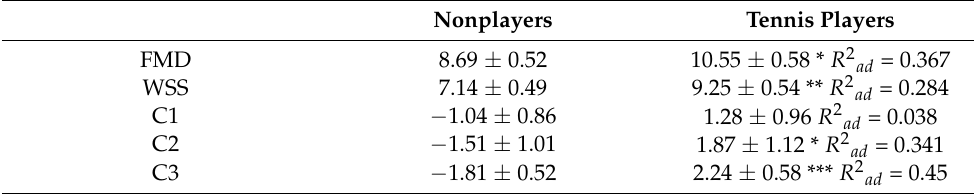
Table 5. Analysis of covariance of the FMD, WSS, Cluster 1, Cluster 2, and Cluster 3, using age as a covariate. Nonplayers Tennis Players